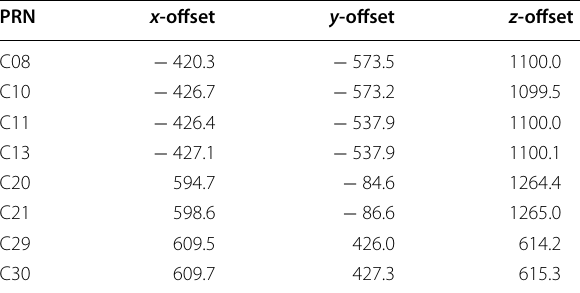
Table 4 Satellite center of mass information (unit: